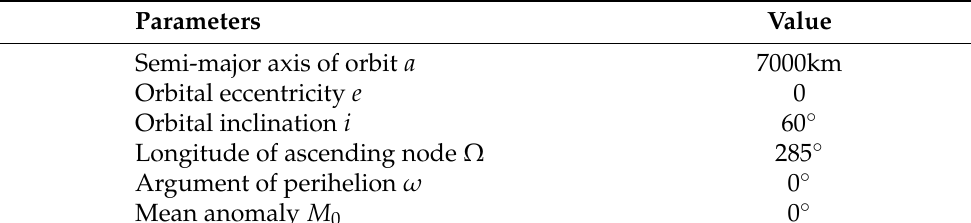
Table 2. Orbital element settings.